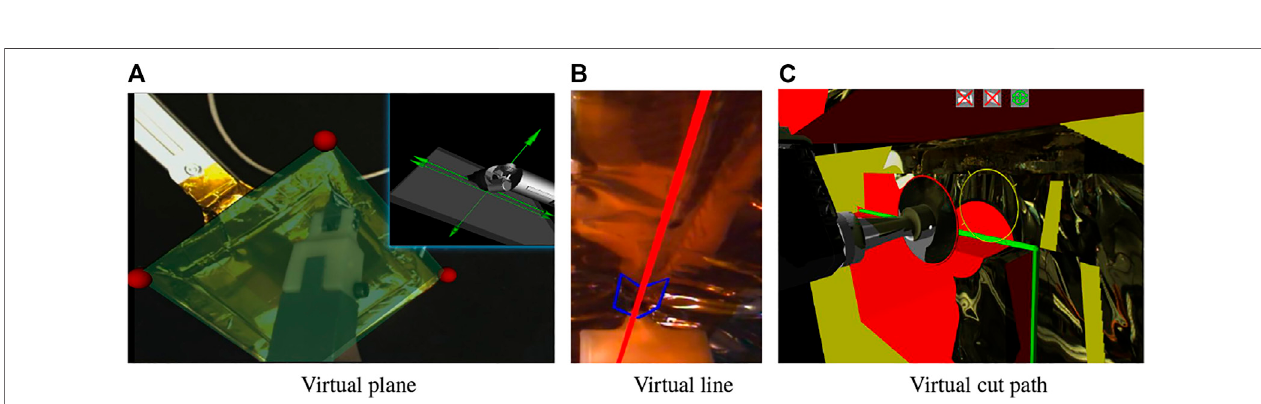
FIGURE 4 | Virtual Fixtures: (A) Virtual plane on (stereo) camera image, Xia et al. (2012); (B) Virtual line (red) on (stereo) camera image; (C) Virtual cut path (green lines) on 3D environment model, Pryor et al. (2019).